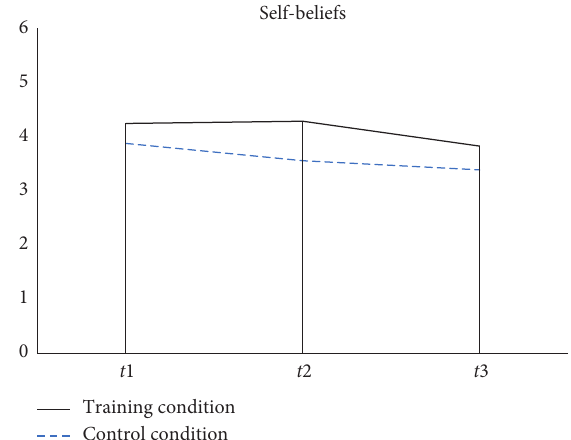
Figure 3: Development of self-beliefs in both conditions.